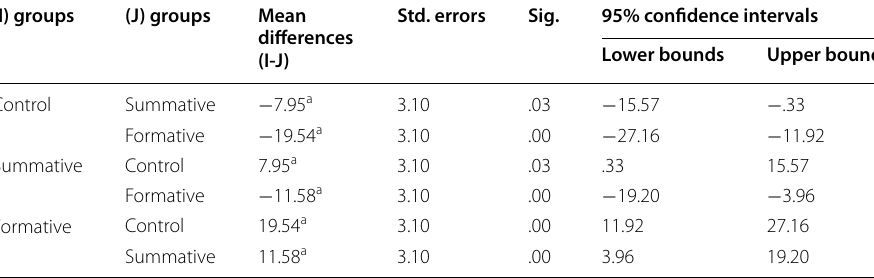
a The mean differences are significant at the 0.05